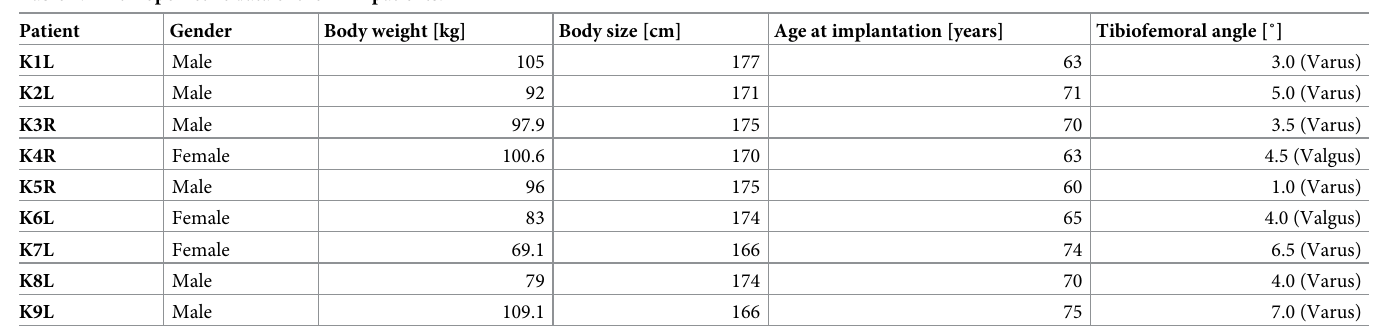
Table 2. Anthropometric data of the TKA